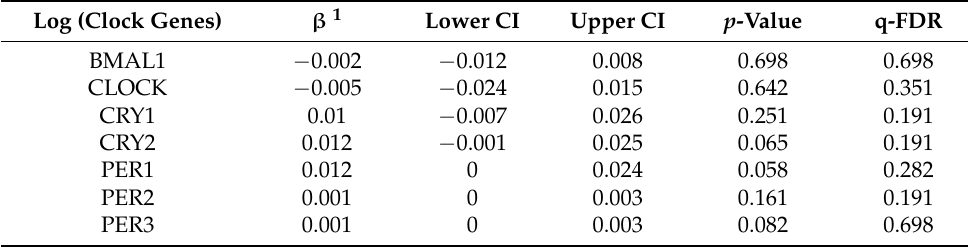
BMAL1: Brain and Muscle Aryl Hydrocarbon Receptor Nuclear Translocator-like Protein-1; CI: Confidence Interval; CLOCK: Circadian Locomotor Output Cycles Kaput; CRY: Cryptochrome Circadian Regulator; PER: Period Circadian Regulator; q-FDR: False Discovery